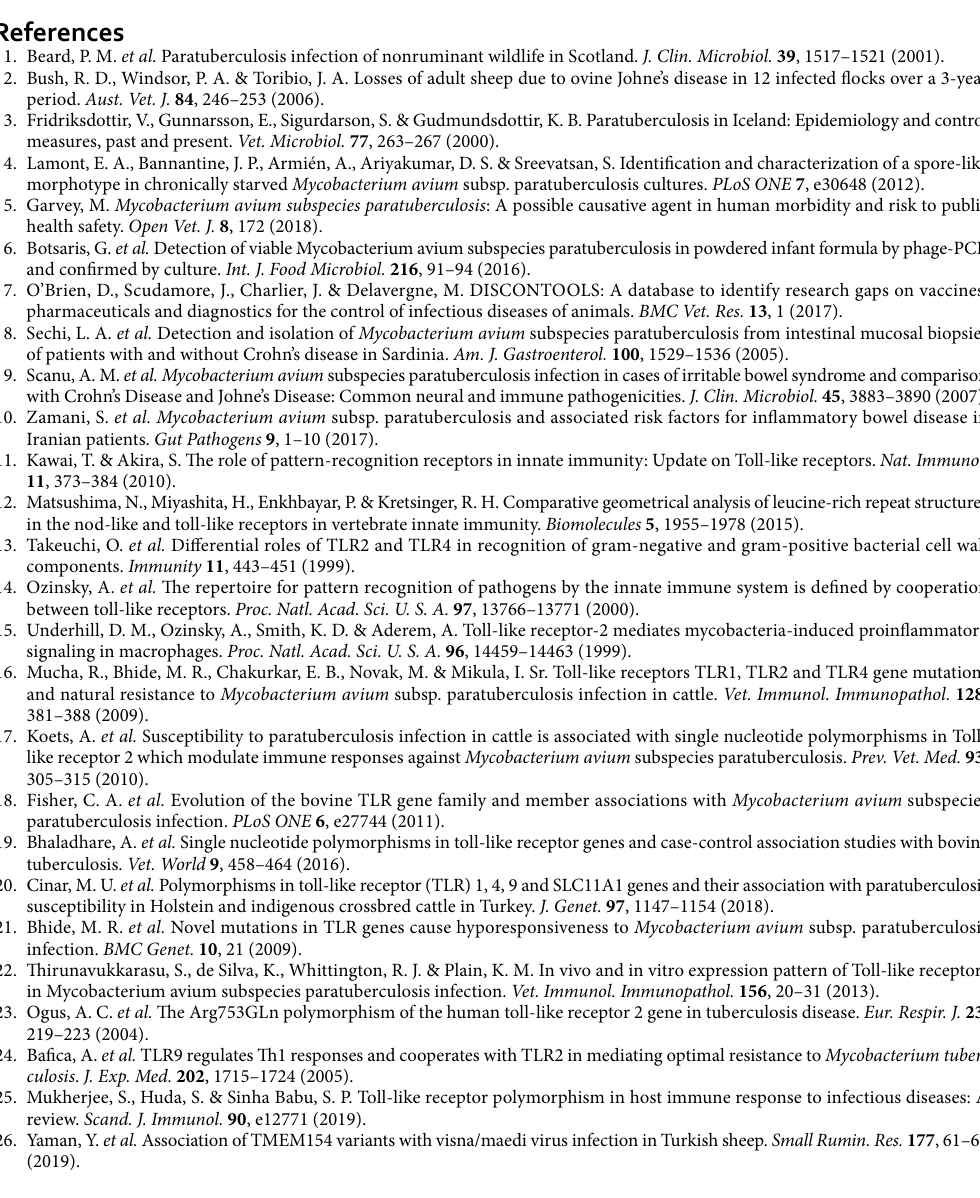
Table 4. McNemar pair classifications in a 2 × 2 contingency table.